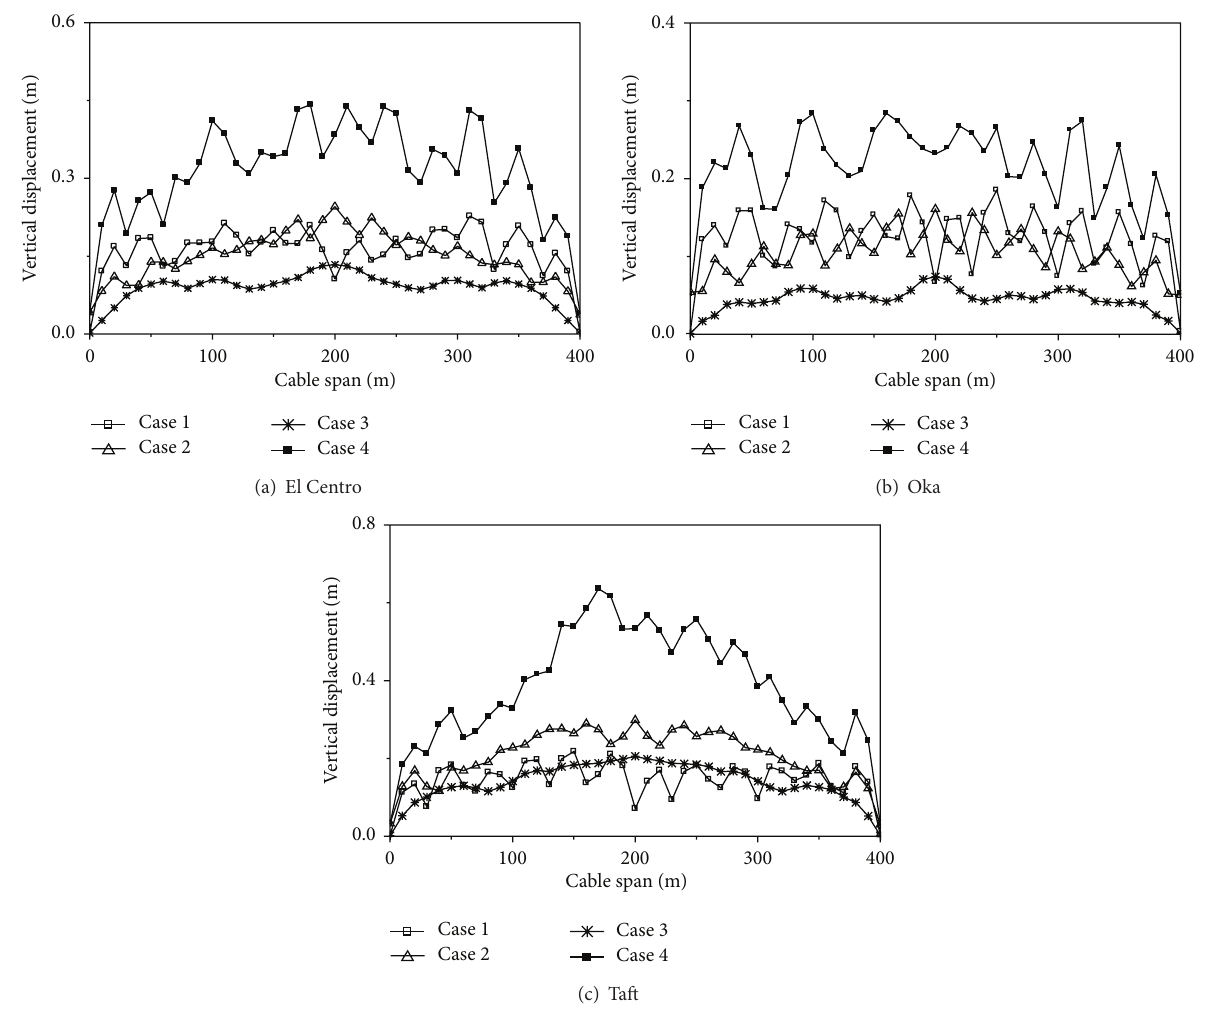
Figure 4: Vertical displacements of the cable under different analysis